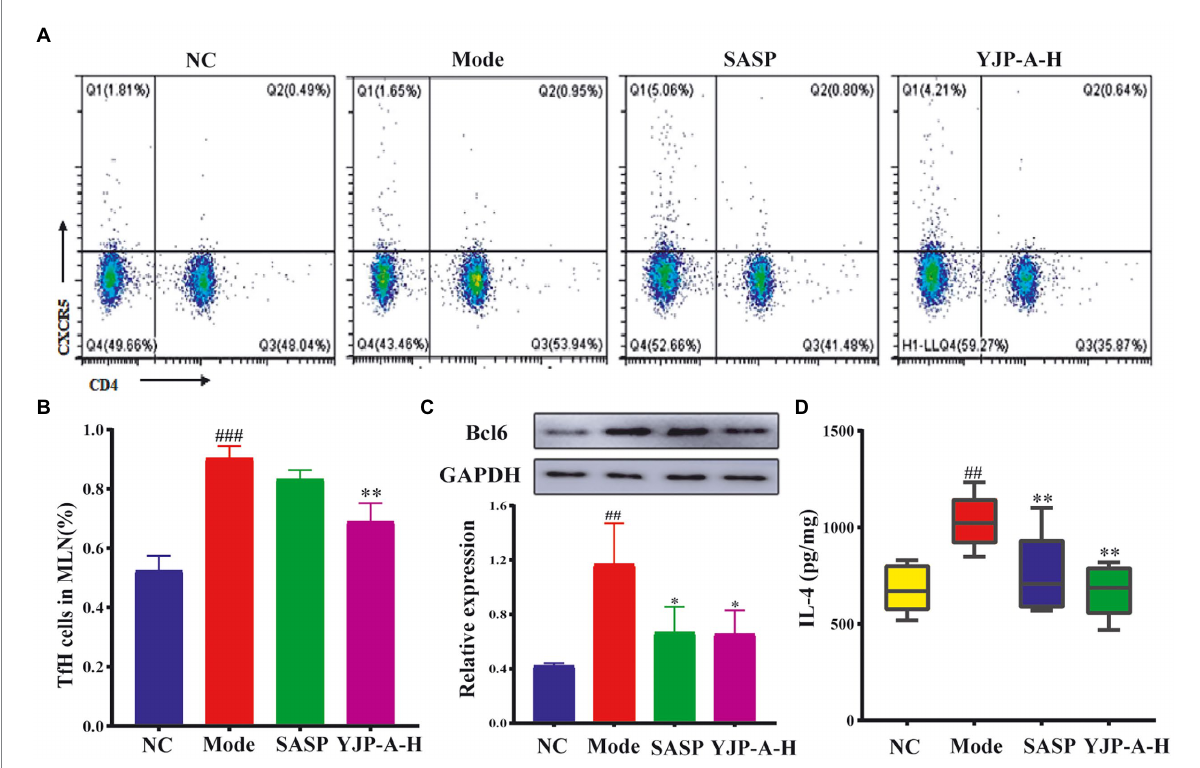
FIGURE 5 Effects of YJP-A-H on changes of Tfh cells (A,B) , the expression of Bcl6 (C) and IL-4 (D) in MLNs. Data are expressed as the mean ± SEM, except for flow cytometry assay n = 3 per group, the remaining analysis n = 5 per group. ## p < 0.01, ### p < 0.001 vs. NC group; * p < 0.05, ** p < 0.01 vs. model